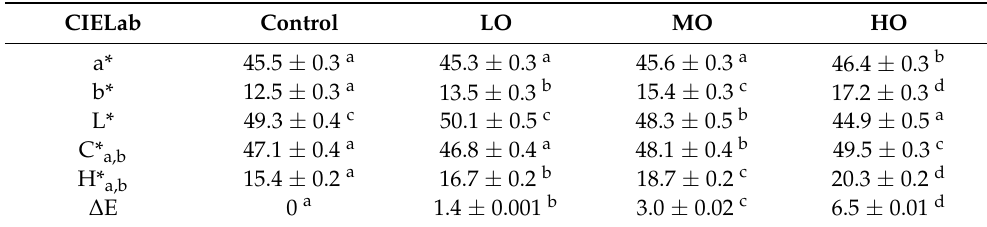
Table 2. The effects of different oxygen exposure levels on CIELab parameters after oxygenation of five phases.